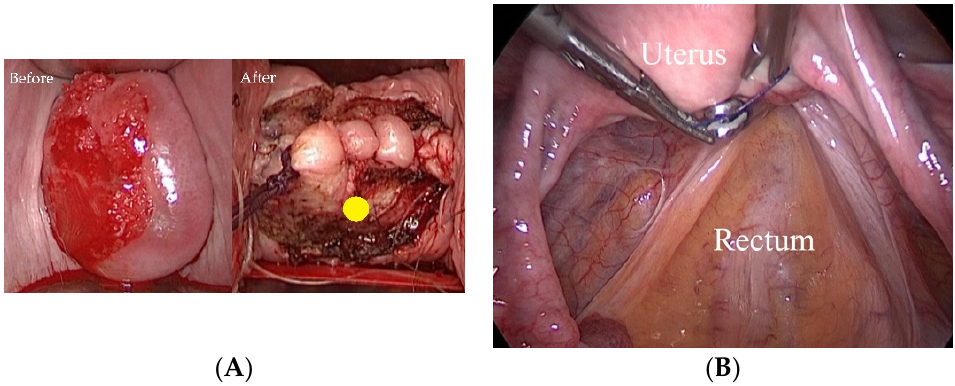
Figure 1. Concept of the “no-look no-touch” technique ( A ) before (left) and after (right) the creation of the vaginal cuff. Before the laparoscopic procedure, we created a cuff to isolate the tumor from the operative field. We placed a trocar (marked with a yellow circle) to prevent it from touching the tumor. ( B ) Manipulation of the uterus without insertion of a uterine manipulator. We use the forceps through the trocar placed in the posterior vaginal fornix to manipulate the uterus by handling the thread around the uterine body.